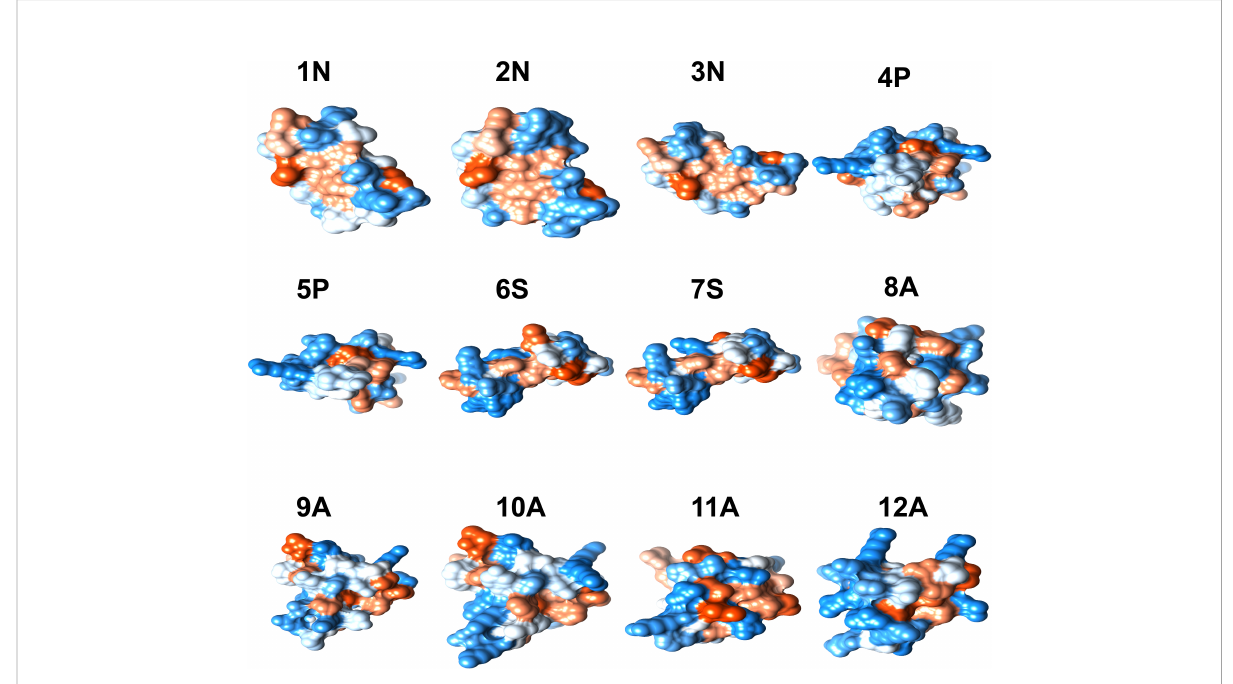
FIGURE 2 3D structure of hydrophobic and hydrophilic regions of peptides with antimicrobial potential modeled in 11 Cnidarian species (Table 3). The blue color represents hydrophilic regions and the orange hydrophobic